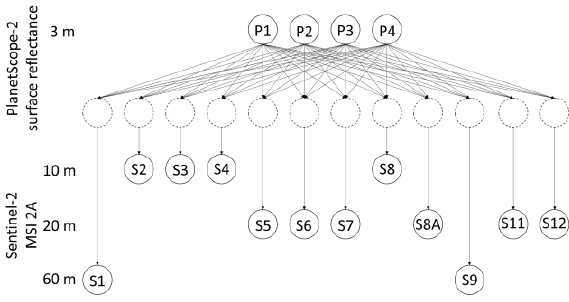
Figure 2 . Neural Network straightforward 12-band Sentinel-2 downscaling to PlanetScope-2 spatial resolution.